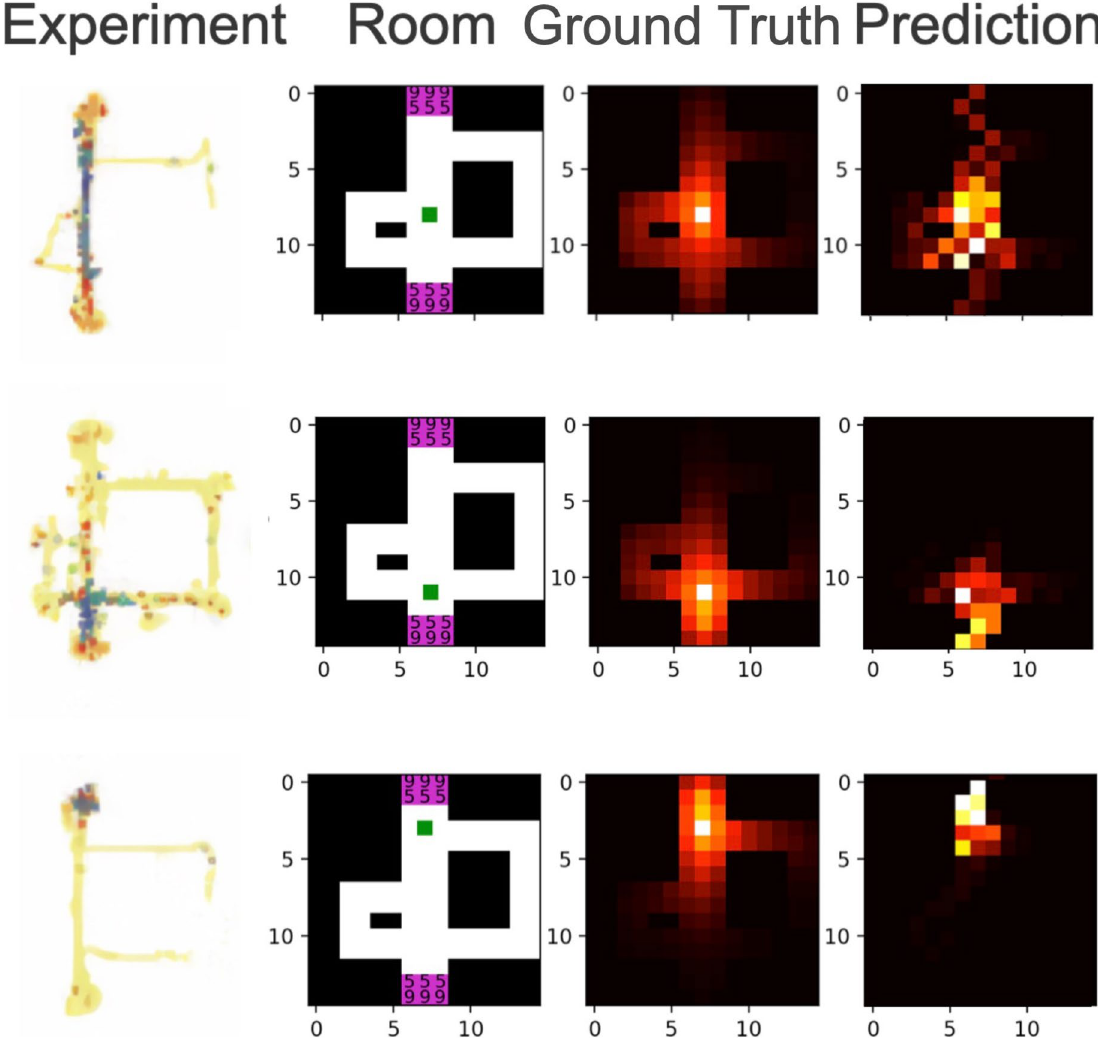
Figure 5. Reinforcement learning to navigate a spatial environment: We reproduced the rat maze experiment published by Alvernhe et al. 36 . (left column). Therefore, we simulated the corresponding maze environment, small green squares indicate three different sample starting positions (second column). Based on the transition probabilities to neighboring states we calculated the successor representation of the maze as ground truth (third column). The predicted SR of the trained network, i.e. the firing patterns of the artificial place cells are very similar to the underlying ground truth (right